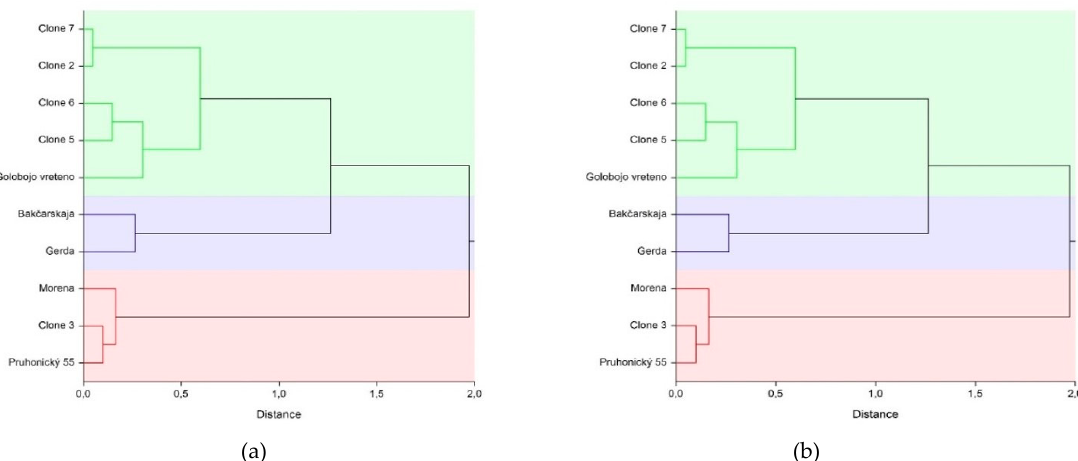
Figure 3. Cluster analysis based on TPC (polyphenols to gallic acid mg L − 1 ) values, year 2018 ( a ) and 2019 ( b ).